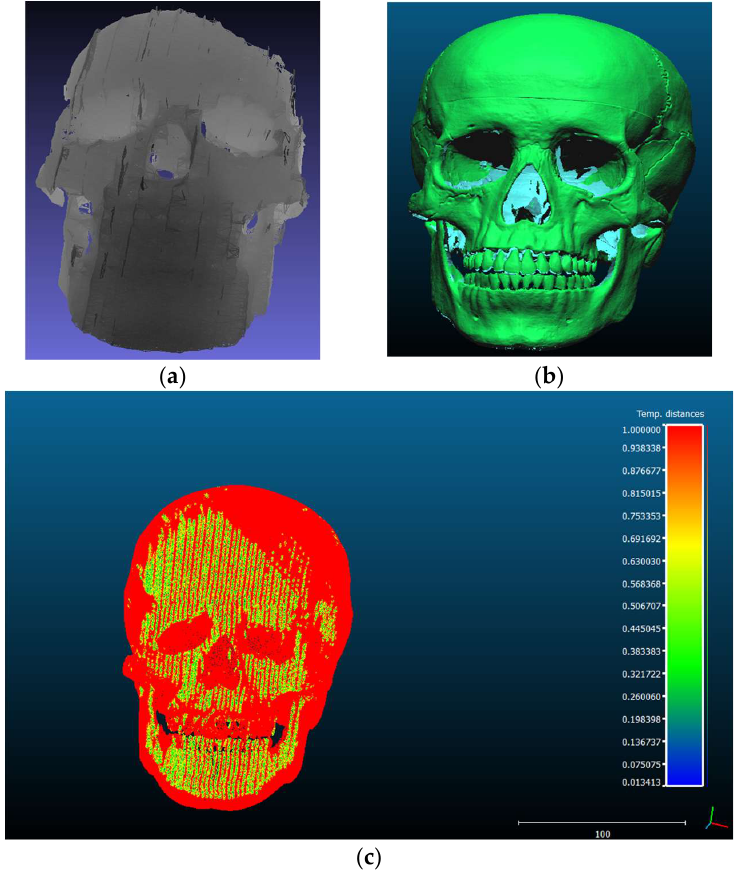
Figure 10. Surface divergence result between the merged point clouds and the 3D model ( a ) merged point clouds of the proposed system; ( b ) the 3D model generated using the 3D scanner; ( c ) Surface divergence estimation between the merged point clouds and the 3D model using CloudCompare software.